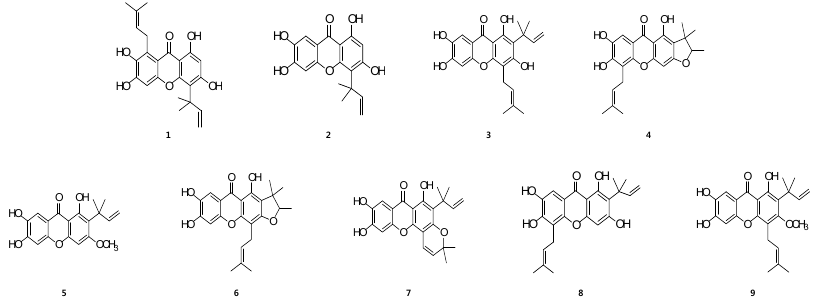
Figure 1. Chemical structures of compounds 1 – 9 .